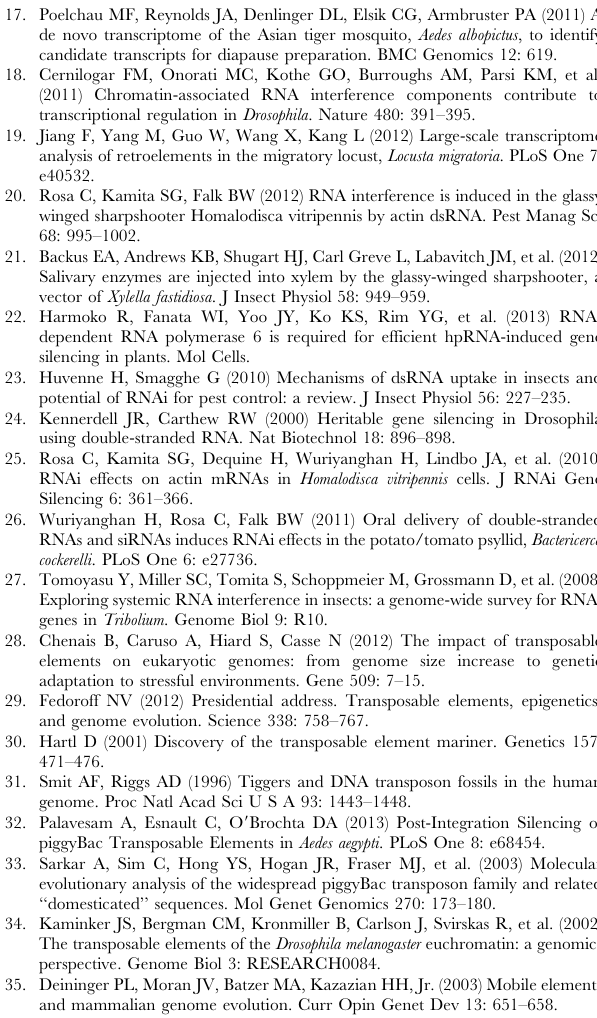
Figure S1 Phylogenetic tree of vacuolar ATPase encoded in the Homalodisca vitripennis transcriptome. The evolutionary relationship of H. vitripennis vacuolar ATPase with other insect vATPase proteins was shown. The evolutionary history was inferred using the Neighbor-Joining method. The percentage of replicate trees in which the associated taxa clustered together in the bootstrap test (500 replicates) is shown next to the branches. The evolutionary distances were computed using the Maximum Composite Likelihood method and are in the units of the number of base substitutions per site. All ambiguous positions were removed for each sequence pair. Evolutionary analyses were conducted in MEGA5. Table S1 Primer pairs designed for the amplification of transcripts from Homalodisca vitripennis whole adults through the use of reverse transcriptase PCR.